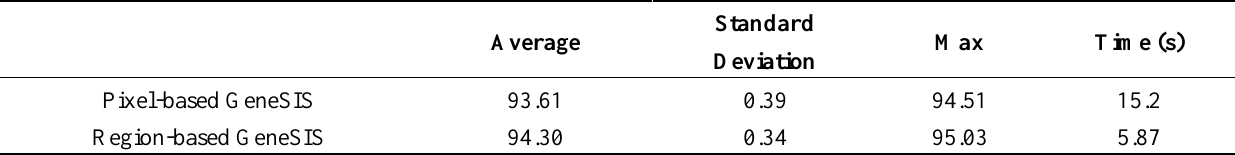
Table 2. Average OA, standard deviation of OA, maximum OA, and execution time for the two GeneSIS versions in Indiana